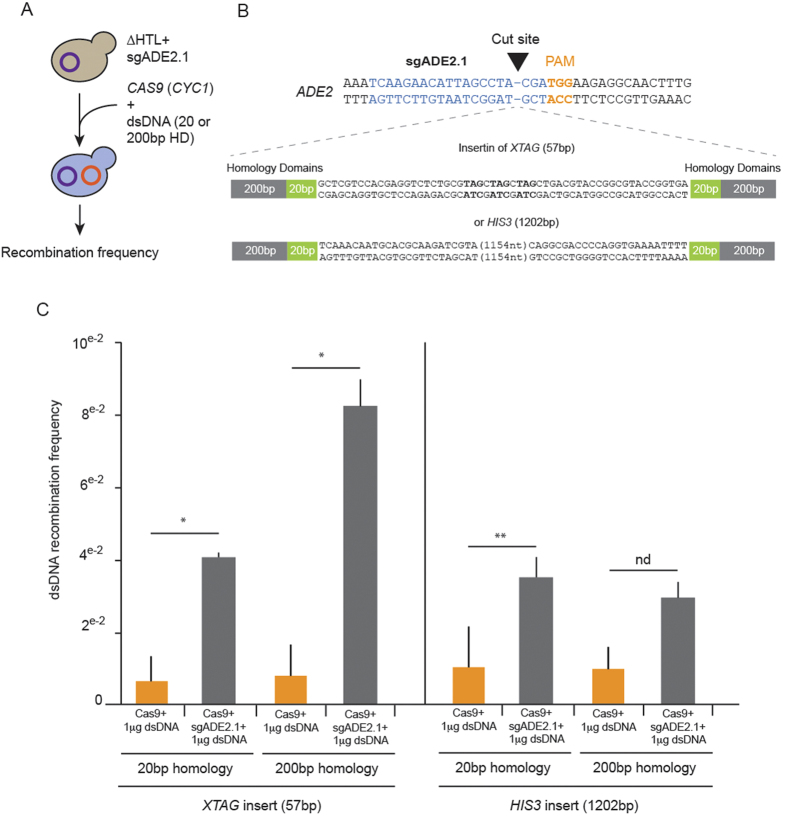
Recombination efficiency in C. glabrata using targeted gene disruption with CRISPR-Cas9.(A) Workflow of C. glabrata expressing sgADE2.1 transformation with CAS9 (CYC1) and either XTAG or HIS3 dsDNA bearing either 20 or 200 bp of homology domain (HD). (B) For homologous recombination, XTAG and HIS3 cassettes were inserted at the sgADE2.1 cut site in ADE2. Sequences of XTAG and HIS3 are listed in Supplementary Fig. 3. For each cassette, we appended either 20 or 200 bp of HD corresponding to the sequence around sgADE2.1 cutting site. (C) ∆HTL strain expressing the sgADE2.1 was transformed with a dsDNA cassette XTAG or HIS3 with or without the pRS314-CAS9 (CYC1). To evaluate efficient recombination at the ADE2 locus, we checked integration of XTAG and HIS3 by PCR after selection of mutants on SCGlc 2% -L-W plates. In each experiment, we tested HR with cassettes bearing 20 or 200 bp-long flanking regions. *p < 0,05, **p < 0,1, nd: not different, each bar represents mean values of n > 200 clones, SEM are shown.